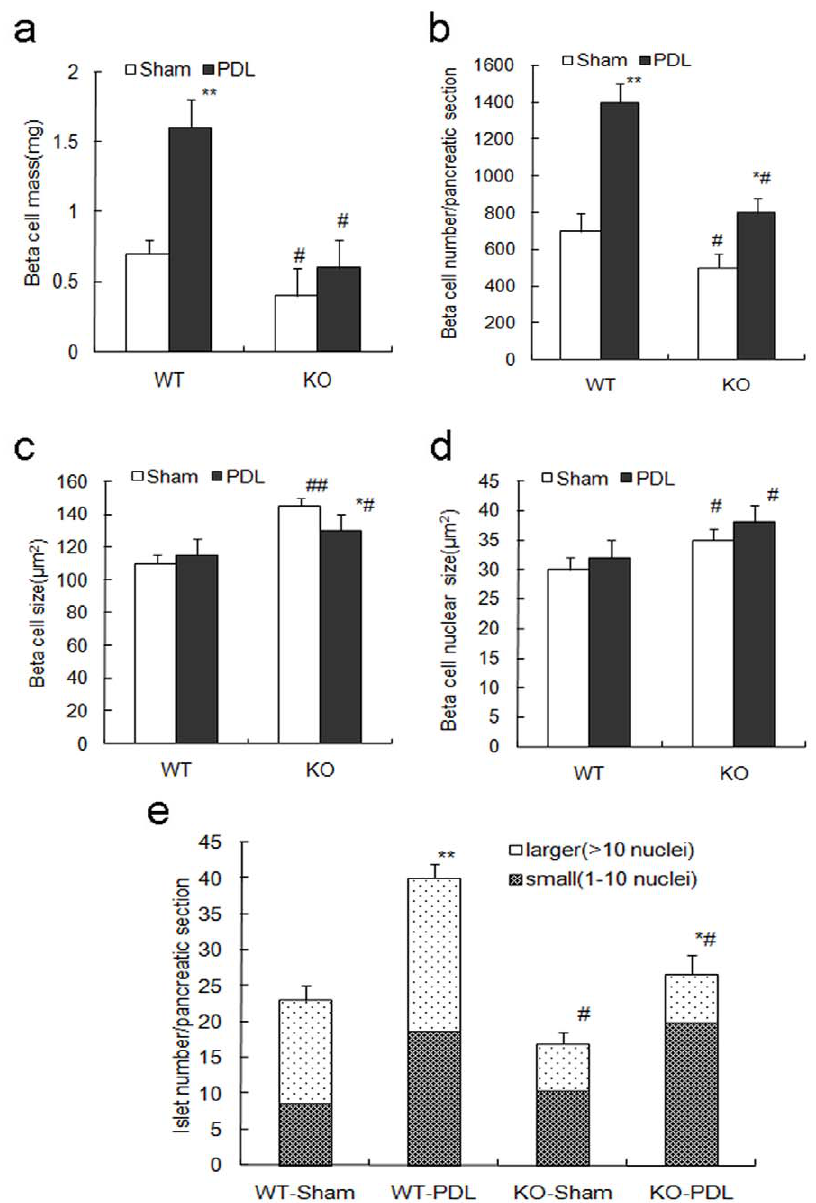
Figure 5. Expansion of beta-cell mass is impaired in RIPCre + Survivin fl/fl mice after PDL. (a) At PDL day 7, beta-cell mass expansion in the tail of pancreas in RIPcre + survivin fl/fl mice is markedly impaired compared to controls (n=5 per genotype). (b) The increment of beta-cell number in the pancreas tail at PDL day 7 is markedly attenuated in the mutant mice compared with that in controls (n=5 per genotype). (c) Beta-cell size is decreased in the pancreas tail of the mutant mice at PDL day 7 compared with that in sham-operated pancreas tail, but is still larger than that in PDL- treated controls (n=5 per genotype). (d) Mutant mice exhibit increased beta-cell nucleus size in the pancreas tail both in PDL and sham-operated groups (n=5 per genotype). (e) The increment of total islet number in pancreas tail at PDL day 7 is attenuated in the mutant mice compared to controls, mainly due to the lack of increase in the number of larger islets (n=5 per genotype). WT, wildtype; KO, knockout. PDL, black bars; sham operation, white bars. The data represent as means 6 SE. *p , 0.05, **p , 0.01 vs sham operation; # P , 0.05, ## p , 0.01 vs